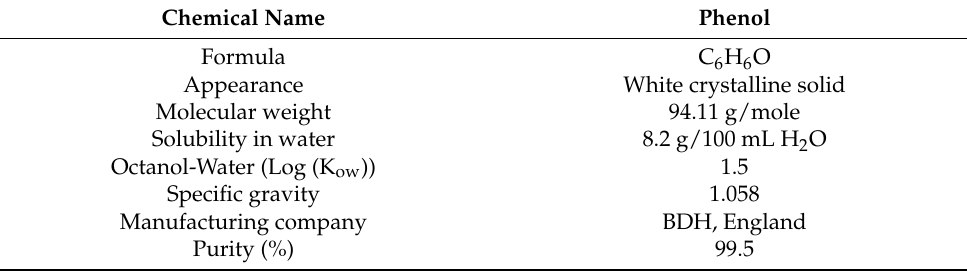
Table 1. Chemical specifications of phenol